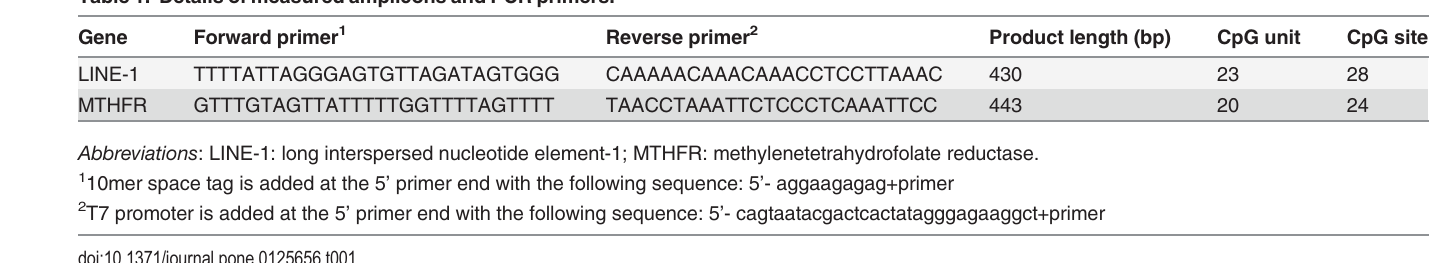
Table 1. Details of measured amplicons and PCR primers.